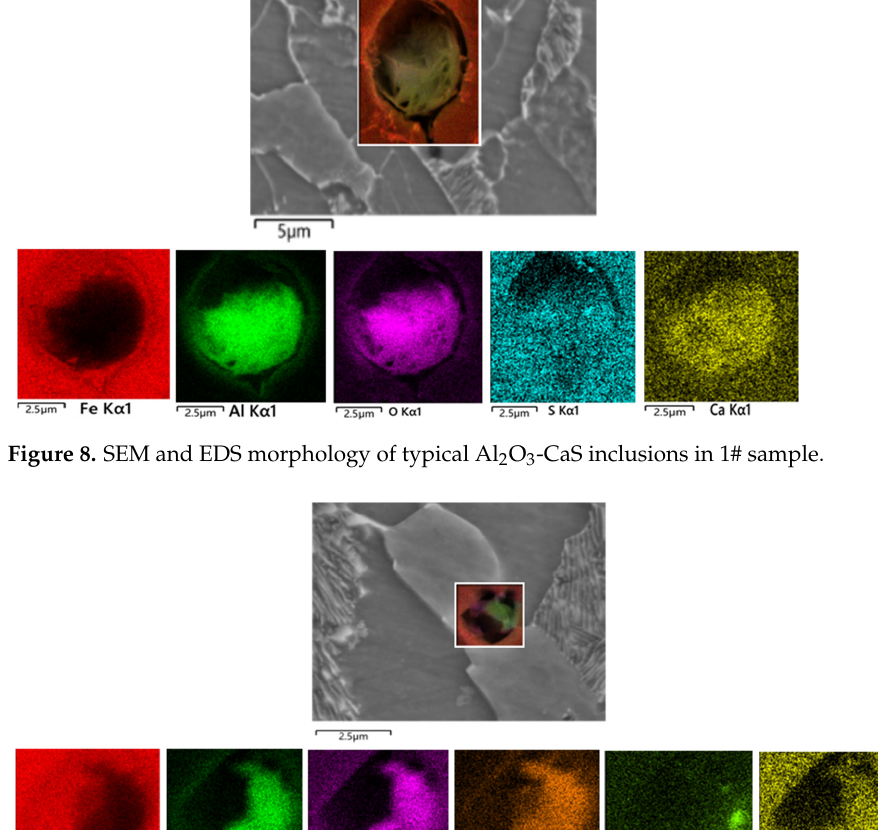
Figure 9. SEM and EDS morphology of typical CeAlO 3 -Ce 2 O 2 S-TiO inclusions in 2# sample.